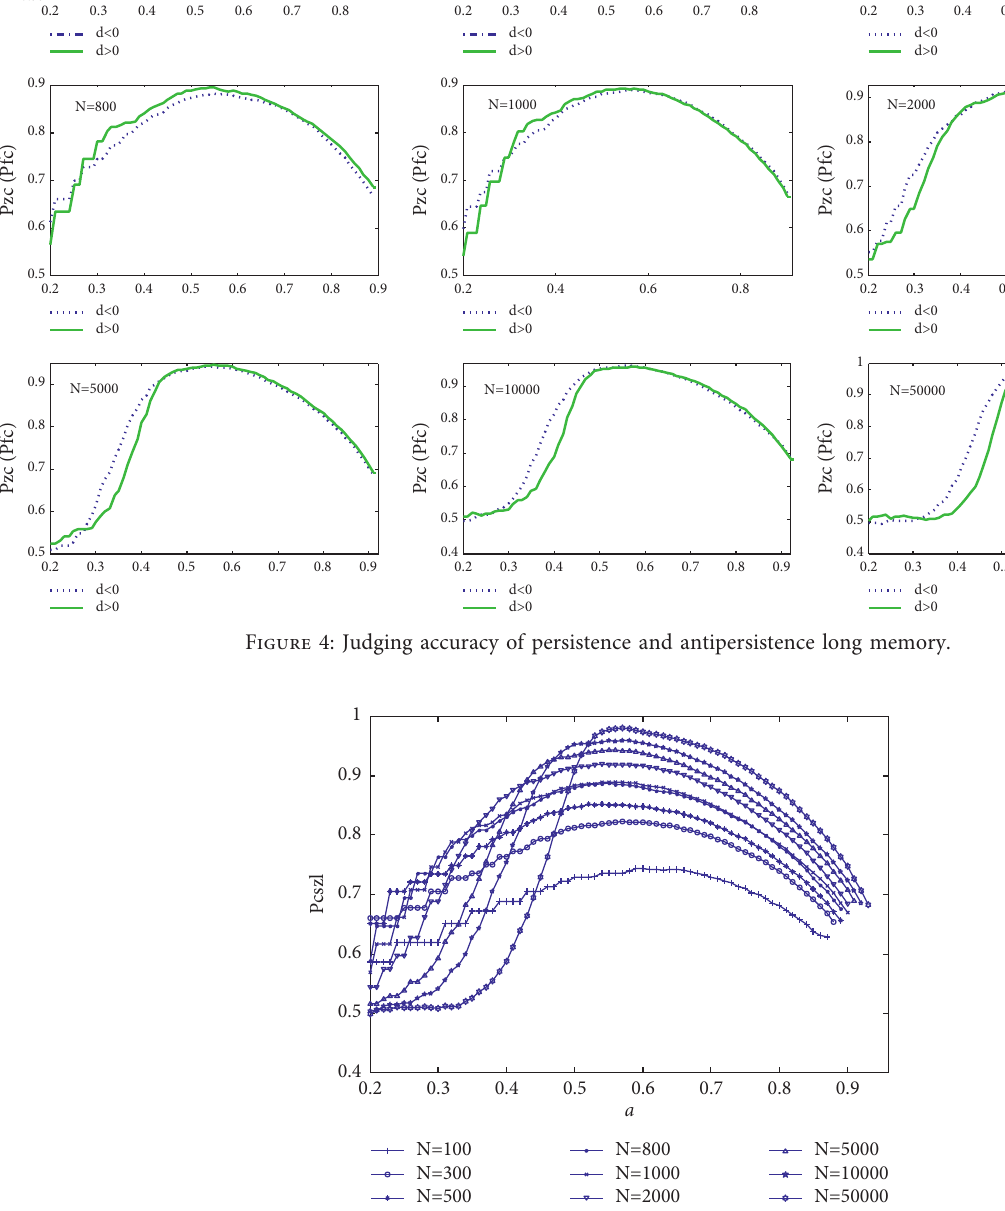
Figure 5: Comprehensive judging accuracy of persistence and antipersistence long